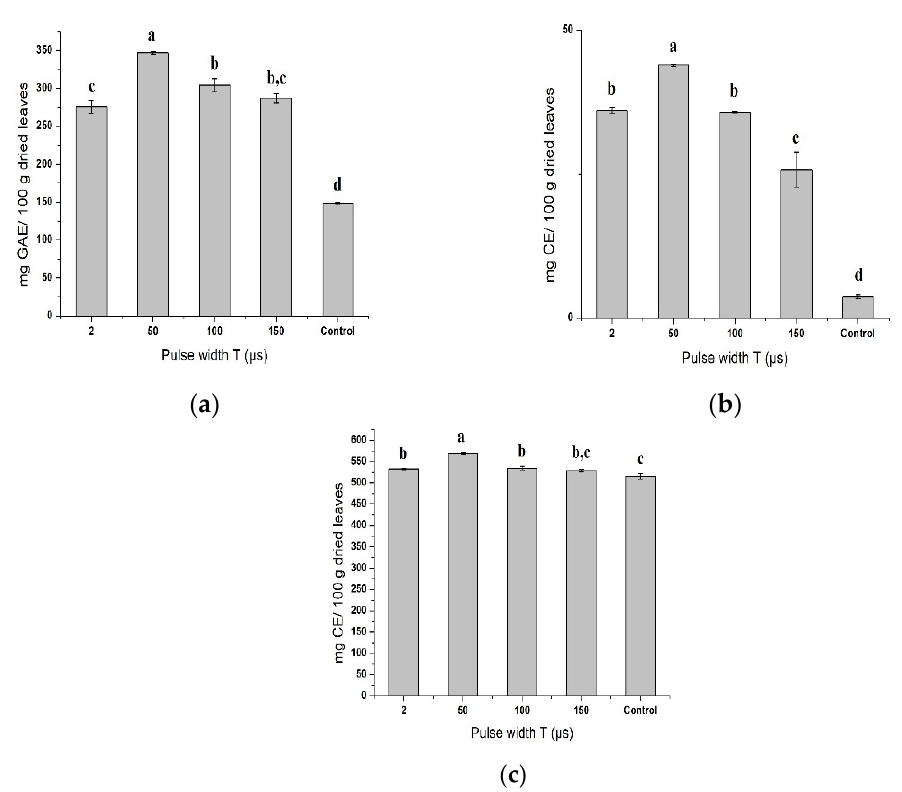
Figure 2. Variation of the phenolic compound extraction yield as a function of the pulse width. ( a ) Total phenolic content; ( b ) Total flavonoid content; ( c ) Condensed tannin content. Means not shar- ing any letters are significantly different.